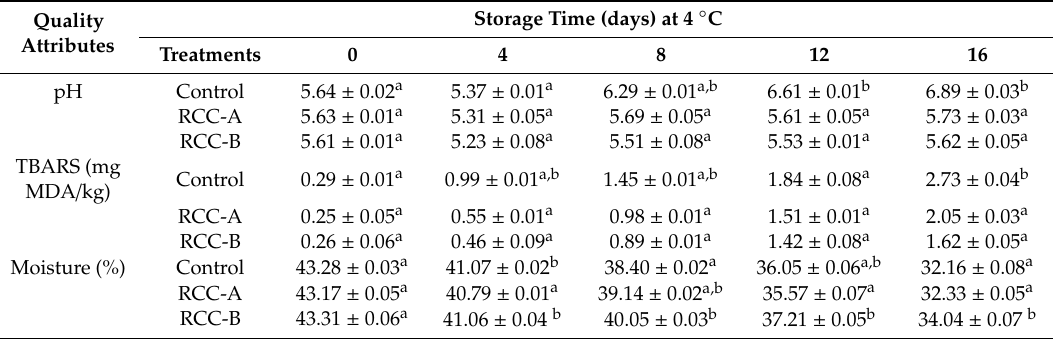
Table 5. The e ff ect of RCC extract on the pH, thiobarbituric acid reactive substances (TBARS), and moisture values of beef during storage at 4 ◦